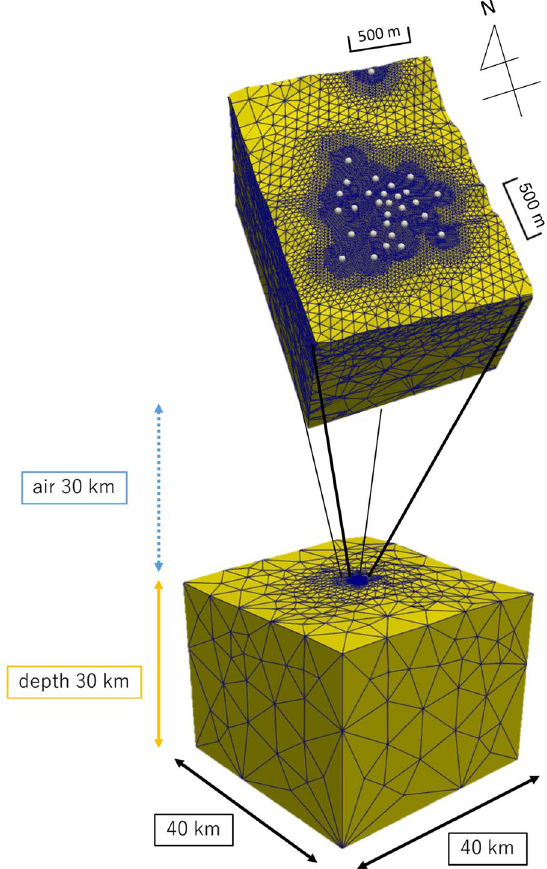
Fig. 4 Calculation domain (lower figure) and its enlargement around the survey area (upper figure). White dots represent the observation sites and navy blue lines indicate the unstructured tetrahedral mesh used in this study